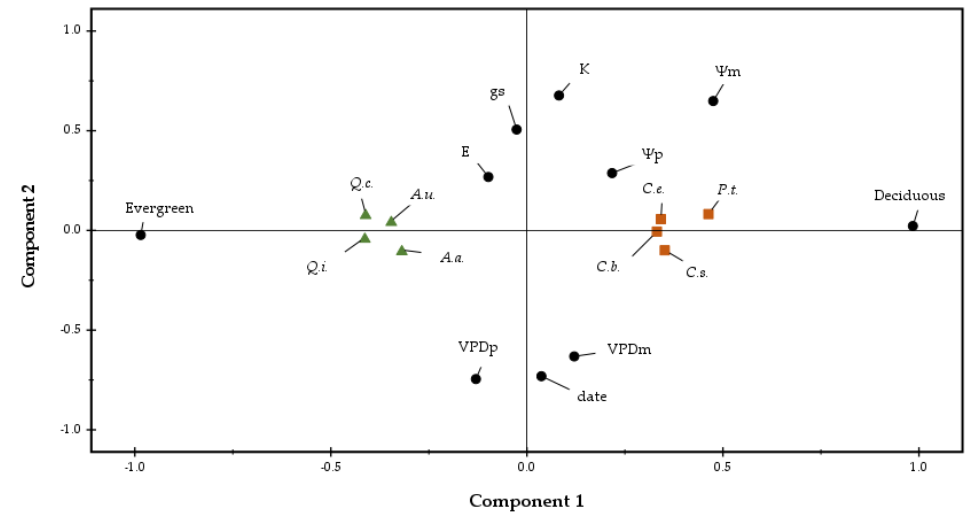
Figure 3. Principal component analysis (PCA) loading plot representing the variables and the species characterizing the two components. Black dots indicated predawn (Ψ p ) and midday (Ψ m ) leaf water potential, midday transpiration rate (E), midday stomatal conductance (g s ), midday leaf hydraulic conductance (K Leaf ) and midday vapour pressure deficit (VPD m ); brown squares indicated the deciduous species: Coronilla emeroides ( C.e .), Carpinus betulus ( C.b .), Pistasia terebinthus ( C.t. ). Cercis siliquastrum ( C.s. ), while green triangles indicated the evergreen species: Arbutus unedo ( A.u .), Arbutus adrachnae ( A.a. ), Quercus coccifera ( Q.c .) and Quercus ilex ( Q.i. ). Table 1. Mean values of predawn (Ψ p ) and midday (Ψ m ) leaf water potential, midday transpiration rate (E), midday stomatal conductance (g s ), midday leaf hydraulic conductance (K Leaf ) and midday vapour pressure deficit (VPD m ) in deciduous and evergreen shrubs during the study period. Parameter